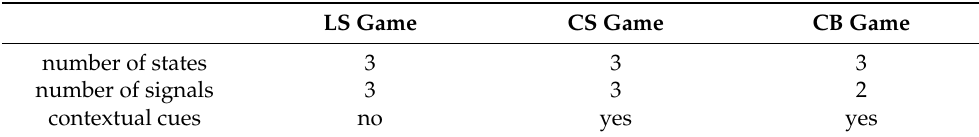
Table 2. Properties of the three games studies in this